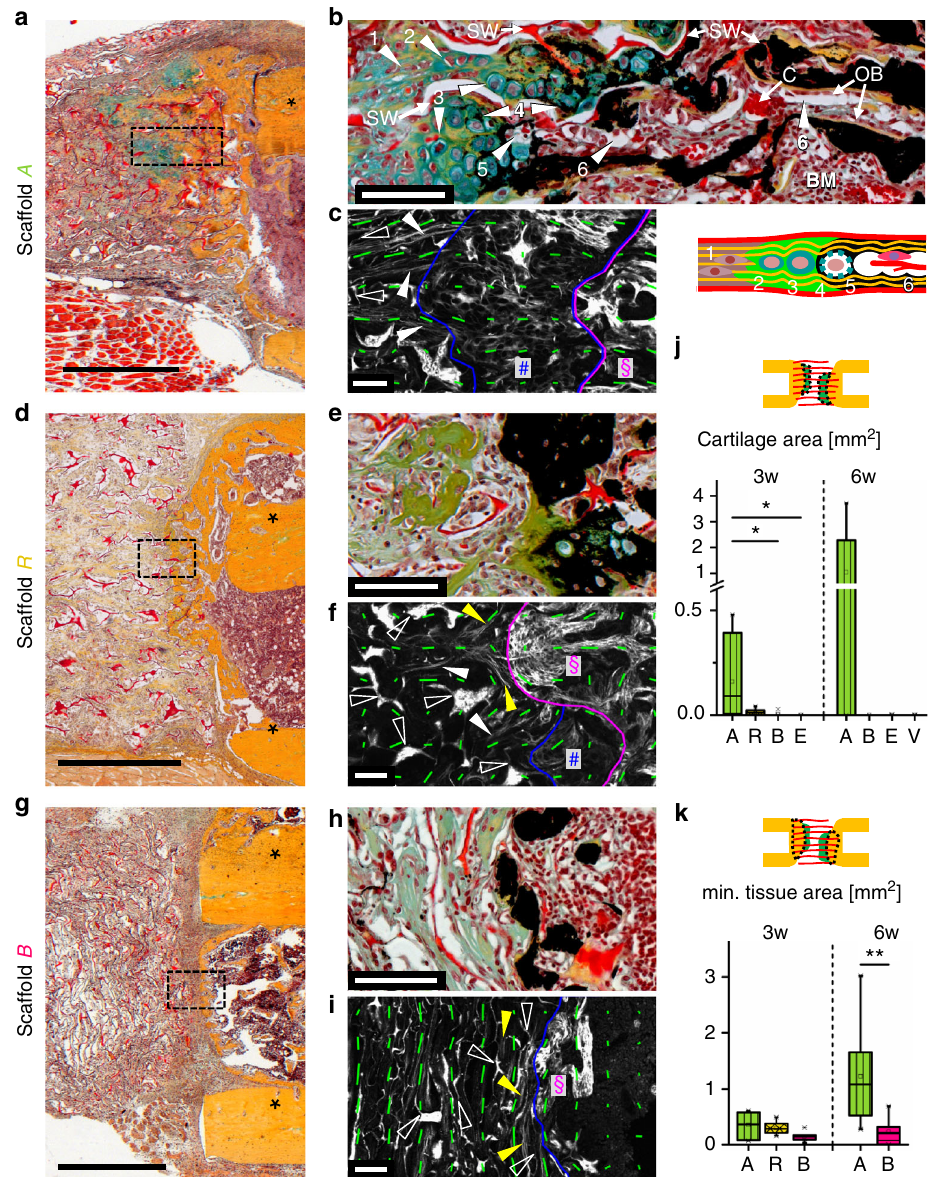
Fig. 5 Biomaterial pore architecture is decisive for the induction of EO. a Movat ’ s pentachrome (MP) staining showing EO in scaffold A characterized by cartilage (green) at the mineralization front 3 weeks post-op. Asterisks indicate cortical bone. b Magni fi cations of the cartilage zone in scaffold A in a combined MP and von Kossa staining (mineralized matrix appears black) showing (1) pre-chondrogenic cells, (2) chondrocytes, (3) hypertrophic chondrocytes, (4) mineralization of surrounding matrix, (5) vacated chondrocyte lacunae, (6) resulting channels populated with cells and blood vessels (see also according sketch). SW indicates scaffold wall (appears red), C blood vessel capillaries, OB osteoblasts, BM bone marrow. c SHG image and local anisotropy (green lines) revealing consistent collagen fi ber orientation during the transition from the pre-cartilage zone (left of blue line) into cartilage (between blue and magenta line, hash symbol) and mineralized matrix (right of magenta line, paragraph symbol). Full arrowheads indicate in vivo formed collagen fi brils, open arrowheads show scaffold walls. d Reduced ingrowth of mineralized tissue into scaffold R vs. A. Only traces of cartilage were found in individual animals (Supplementary Fig. 2e). e Vanishing of EO in scaffold R (3 weeks post-op) indicated by the entrapment of hypertrophic chondrocytes into mineralized matrix associated with local collagen fi ber alignment parallel ( f , yellow arrowheads). g Ingrowth of bone into scaffold B was found rarely. h Except of individual chondrocytes in one animal (Supplementary Fig. 2f), no cartilage was found at the mineralization front. i Collagen fi bers were predominantly aligned parallel to the mineralization front. j , k Boxplots of histomorphometric data obtained from MP stainings for scaffolds A, R, B, empty defect (E), and Vitoss ® (V), 3 and 6 weeks post-op with j total cartilage area and k mineralized tissue area inside the scaffold. Boxplots show the median, 25th, and 75th percentile values (horizontal bar, bottom, and top bounds of the box), whiskers indicate 1.5-fold IQR, open squares indicate means, crosses represent max./min. values. Signi fi cance via Mann – Whitney test (two-sided) with Bonferroni correction; * p < 0.05, ** p < 0.01, n = 6 – 7 animals (3 weeks) and 6 – 8 (6 weeks) per group. Scale bars for a , d , g 1 mm; b , c , e , f , h , i 100 μ